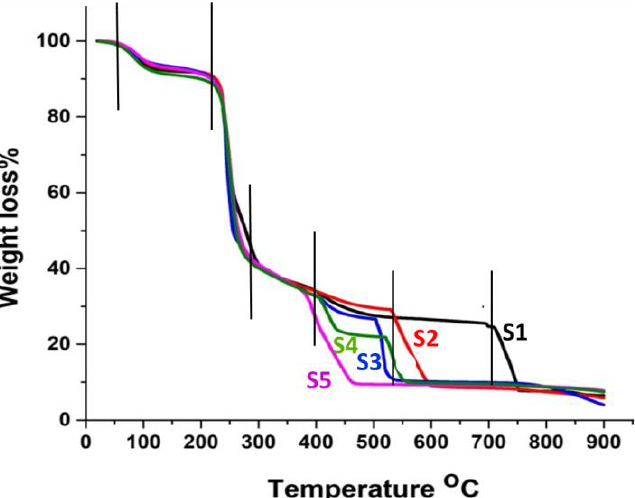
Figure 4. Thermogravimetric curve of the MOE/SA/PVA with a heating rate of 10 ºC/min and under air atmosphere.